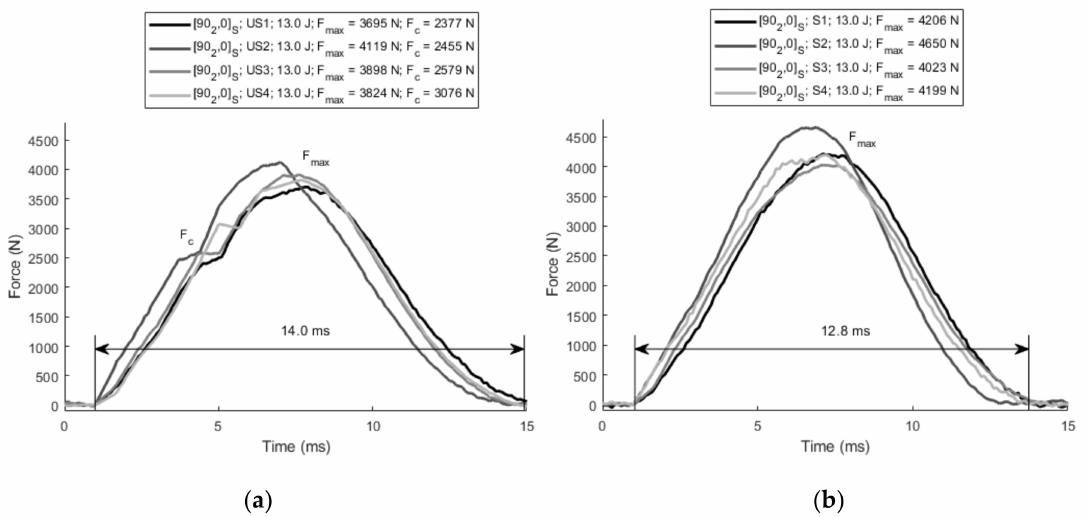
Figure 9. ( a ) Force in unstitched [90 2 , 0] S laminates at 13 J; and ( b ) force in stitched [90 2 , 0] S laminates at 13